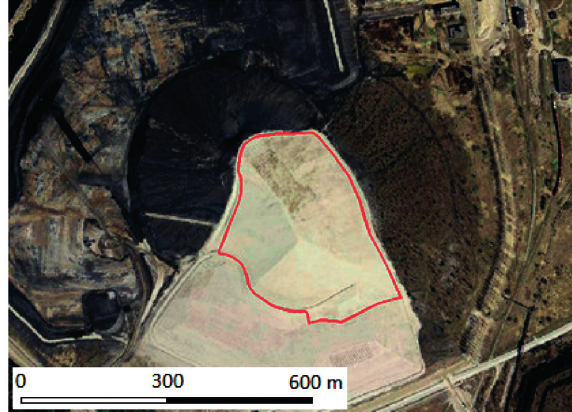
Fig. 2. The TLS-survey area (outlined by the red line) on the top part of the Kiviõli semi-coke hill (Ortophoto, Estonian National Land Board